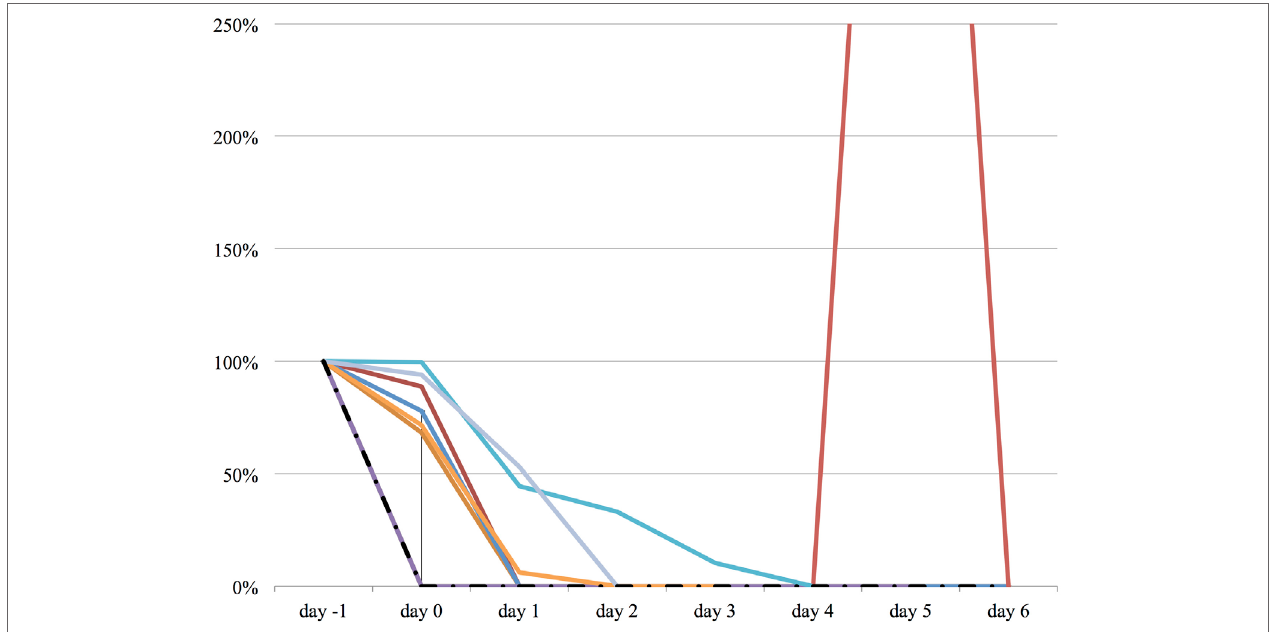
FigUrE 4 | The relative change in propofol dose from day − 1 to day 6 . The vertical axis represents percent change of propofol dose of each patient, compared to day − 1. The dashed line represents the median propofol dose, and the range represents the interquartile range.